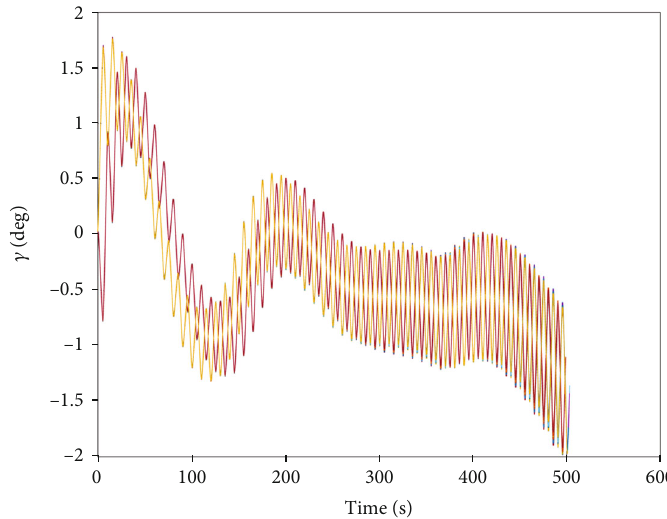
Figure 30: Elevation angles in the Monte Carlo simulations.